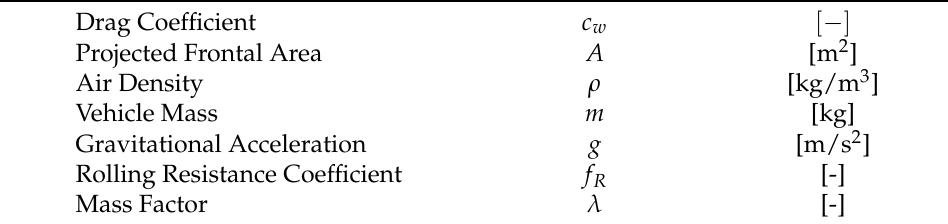
Table 1. Parameters and units of the driving